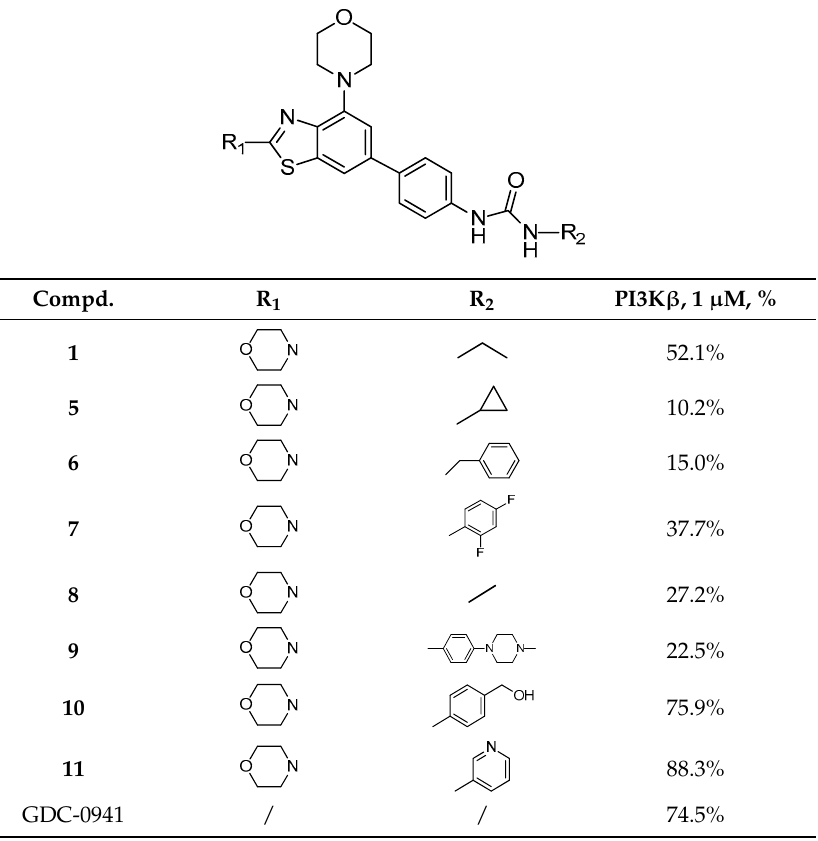
Table 3. Enzymatic activities of compounds 10 and 11 against PI3K α , β , γ , δ and mTOR (IC 50 , μ M). Compd.